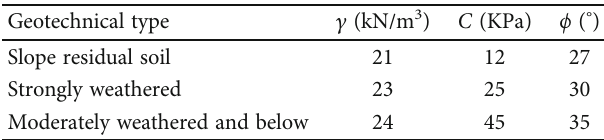
Table 1: Reference value of the physical and mechanical property parameters of residual slope soil.